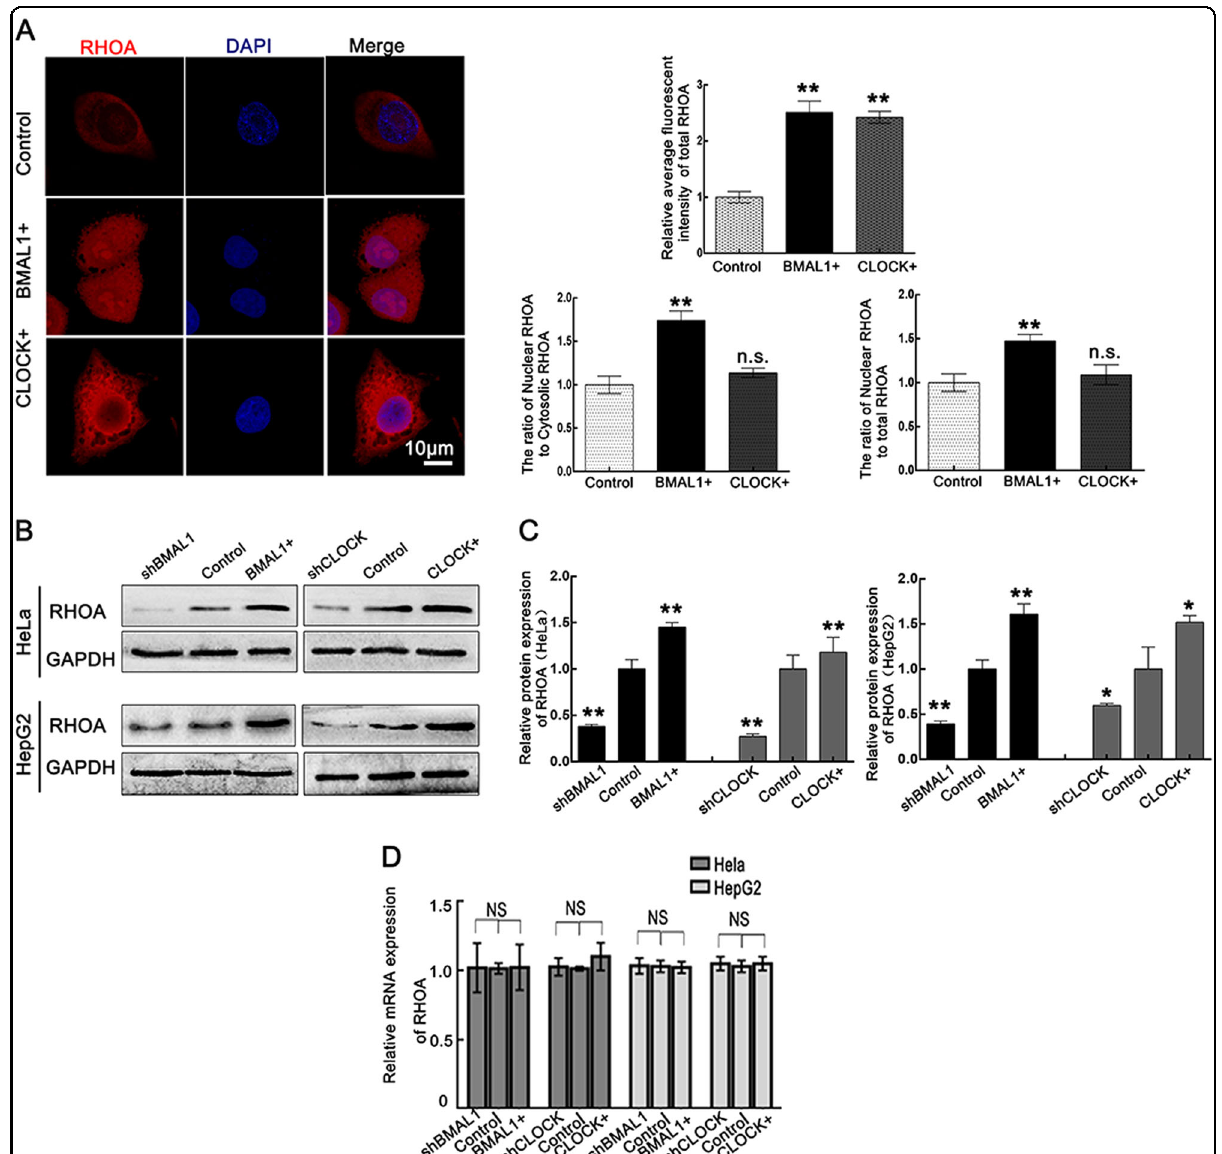
Fig. 3 CLOCK and BMAL1 upregulate the expression of RHOA protein. a Immuno fl uorescent staining of RHOA (Red) in BMAL1 + , control, and CLOCK + HeLa cells (left panel). Nuclei were stained with DAPI. The scale bars represent 10 μ m. The quanti fi cation of RHOA was performed with ImageJ and analyzed (right panel) ** p < 0.01. b , c Expression of RHOA at the protein level was examined using western blotting in shBMAL1, BMAL1 + , shCLOCK, and CLOCK + HeLa cells. RHOA expression was quanti fi ed with ImageJ and then normalized to GAPDH expression. The protein level of the control was taken as 1. Data were analyzed using a t test ( n = 3) and presented as the mean ± sd; * p < 0.05; ** p < 0.01. d Expression of RHOA at the mRNA level was examined by qPCR in shBMAL1, BMAL1 + , shCLOCK, and CLOCK + cells. Data are presented as the mean ± sd ( n = 3); n.s.